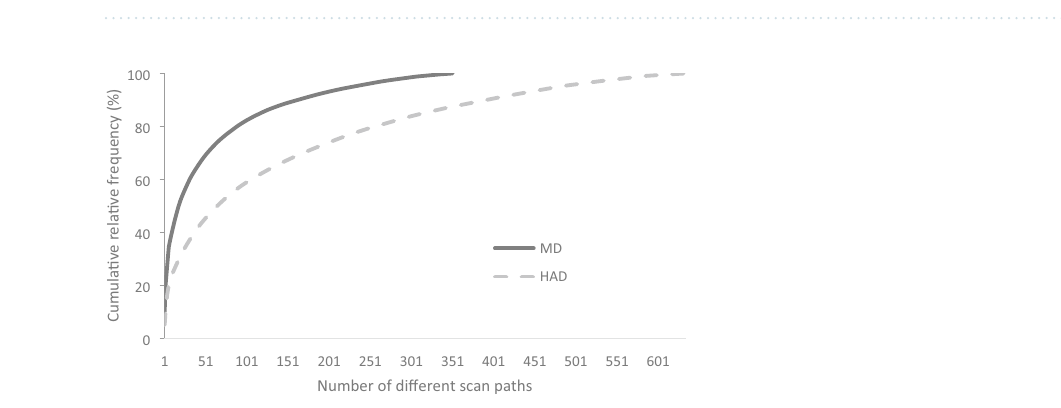
Figure 2 . Top. Percentage of different scan paths observed relative to the theoretical number of possible AOI permutations (100%, dotted line on the figure) along with scan path length. Bottom. Number of different scan paths observed depending on scan path length and theoretical number of possible AOI permutations. Note that the scale on the left is linear, while the scale on the right is logarithmic. For Manual Driving (MD) in dark grey and Highly Automated Driving (HAD) in light grey.